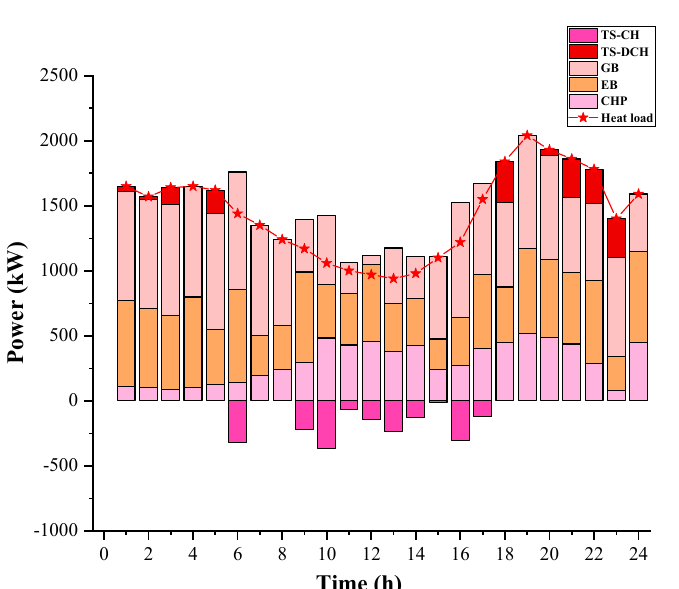
Figure 9. Thermal power balance.